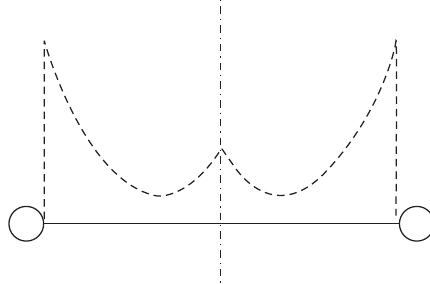
Figure 11: Distribution trend of peak stress absolute value on blastholes